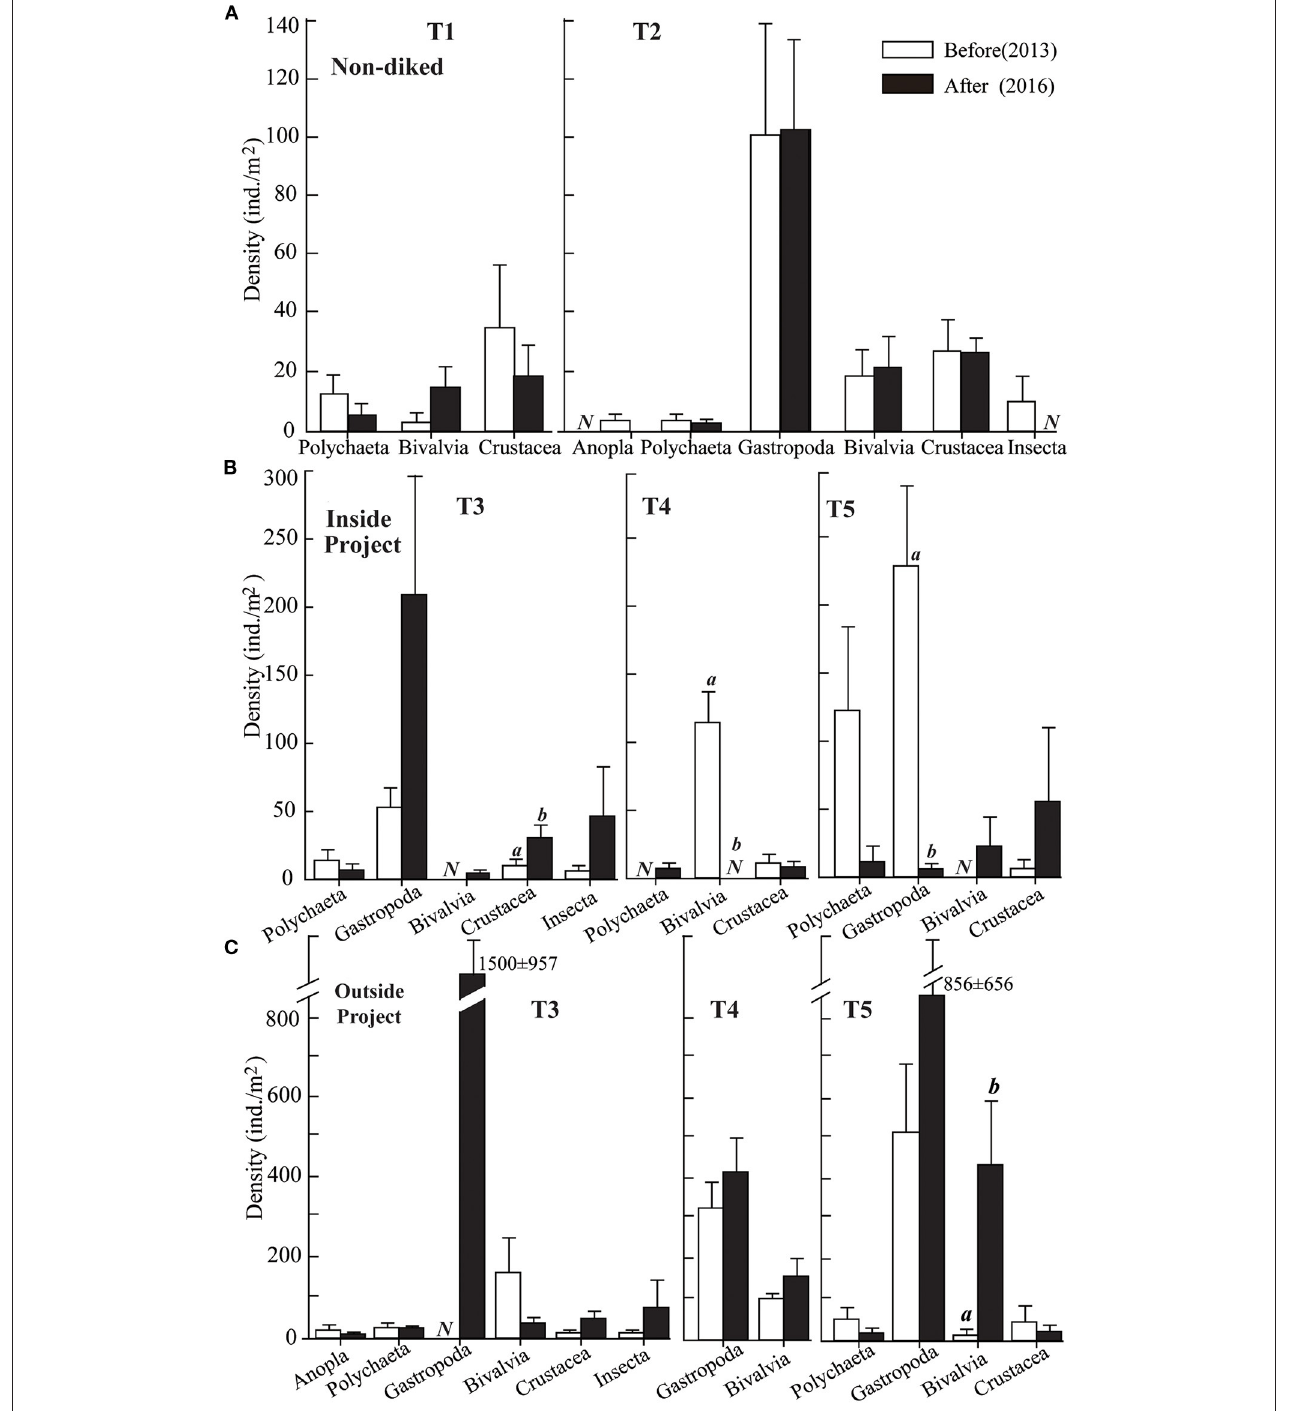
FIGURE 6 | Mean density of macrobenthos groups before (2013) and after (2016) the diking project in the non-diked area transects (A) , inside transects (B) , and outside transects (C) of the project in the Chongming Dongtan salt marsh, Yangtze Estuary, China. Error bars indicate the SE of the mean. Different lowercase superscript letters ( a , b ) refer to significant differences before and after the diking project, respectively ( t -test, P < 0.05).